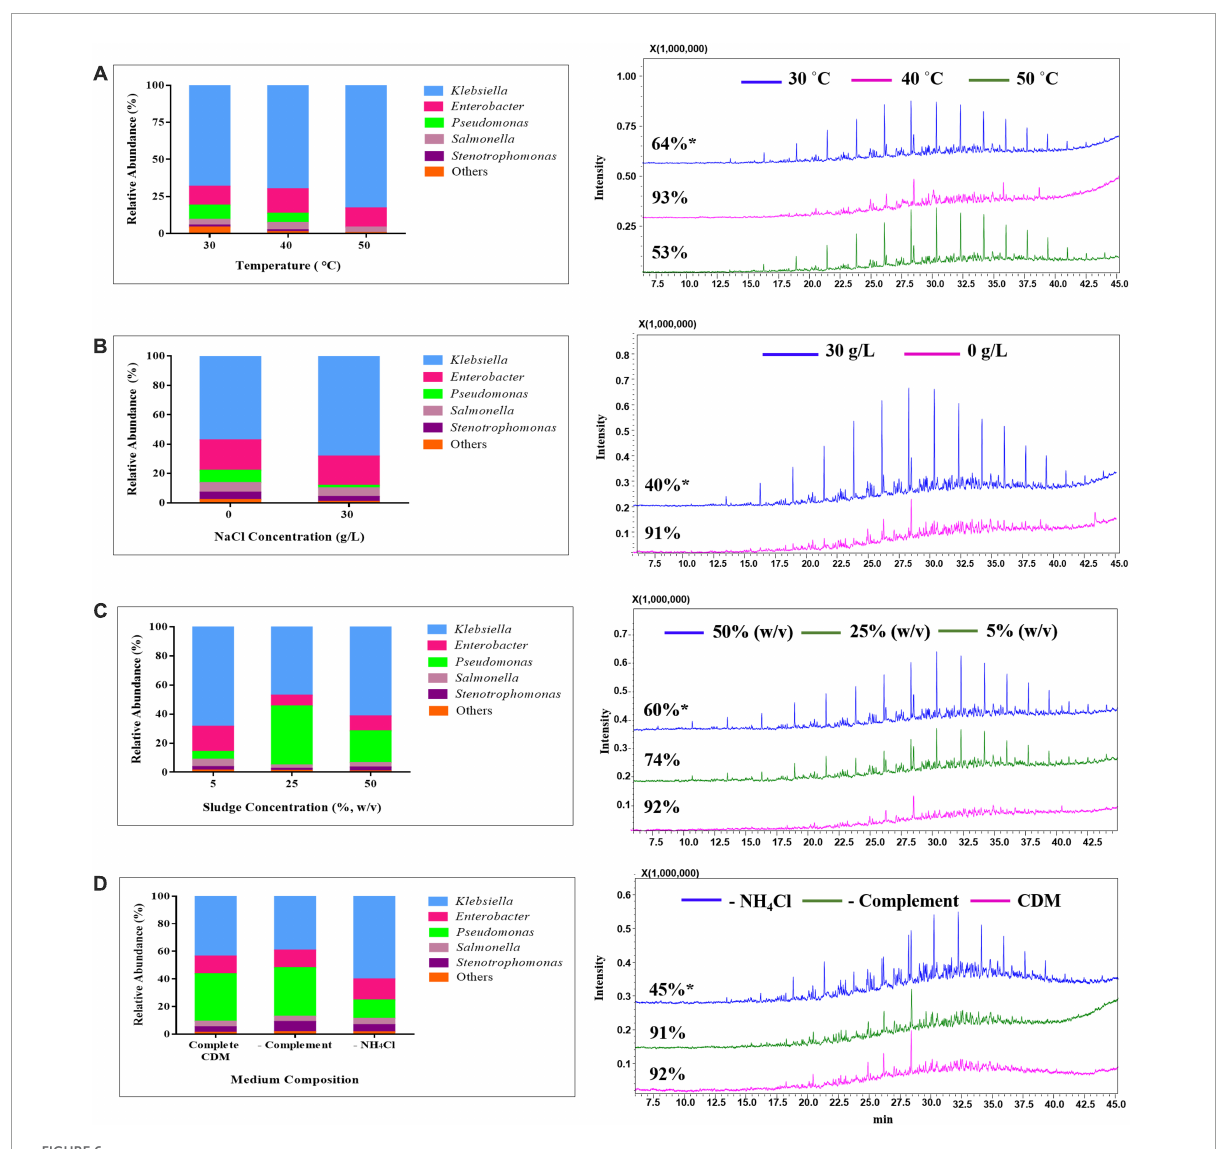
FIGURE6 Biodegradation of oily sludge hydrocarbons and impact of temperature (A) , NaCl concentrations (B) , sludge concentration (C) and medium composition (D) , on the bacterial composition of the consortium AK6 at genus level. *: % hydrocarbon